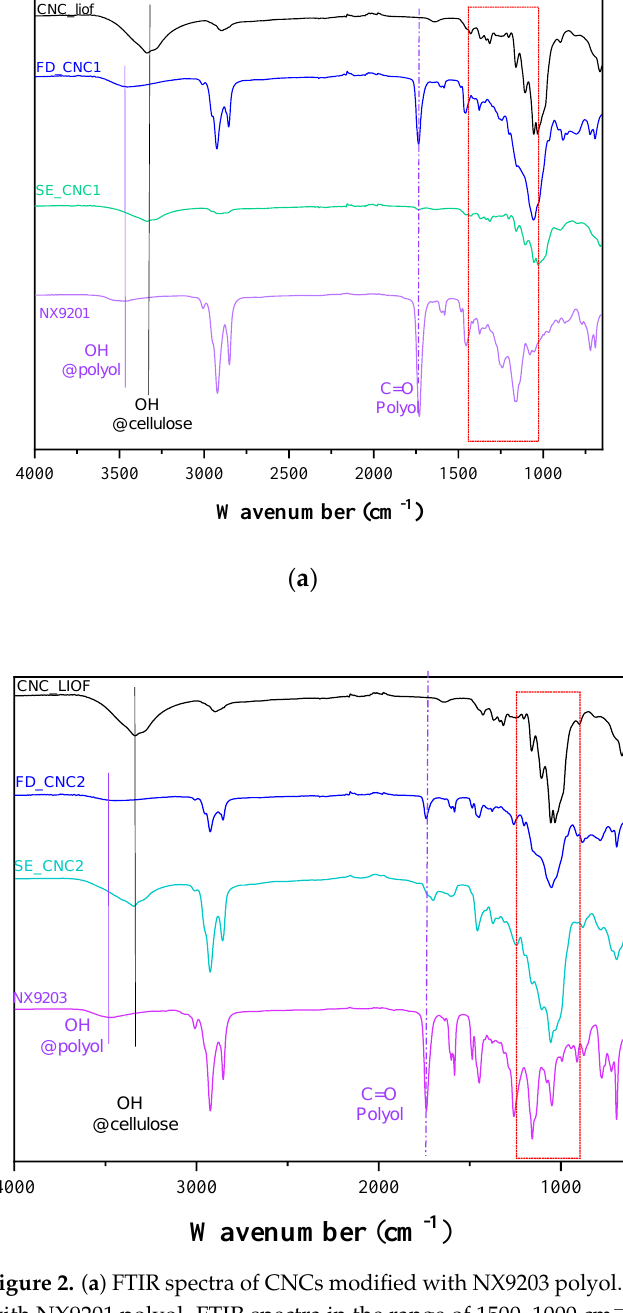
Figure 2. ( a ) FTIR spectra of CNCs modified with NX9203 polyol. ( b ) FTIR spectra of CNCs modified with NX9201 polyol. FTIR spectra in the range of 1500–1000 cm − 1 are pointed out in the red box. For un-functionalized FD_CNCs, three degradation stages (Figure 3a, black curves) were recorded: one main degradation step occurring around 300 ◦ C (with a weight loss of 70 wt%), due to the water evaporation and rearrangement of the CNCs, a second step (with a mass loss of around 10%) in the range 310–400 ◦ C due to the degradation of CNCs linked to the sulphate groups (which were generated during the hydrolysis with sulphuric acid during the CNCs extraction process [58]) and a third peak of degradation due to the cross-bridging and aromatic cyclization of charred residue at 700 ◦ C of around 8 wt%, respectively